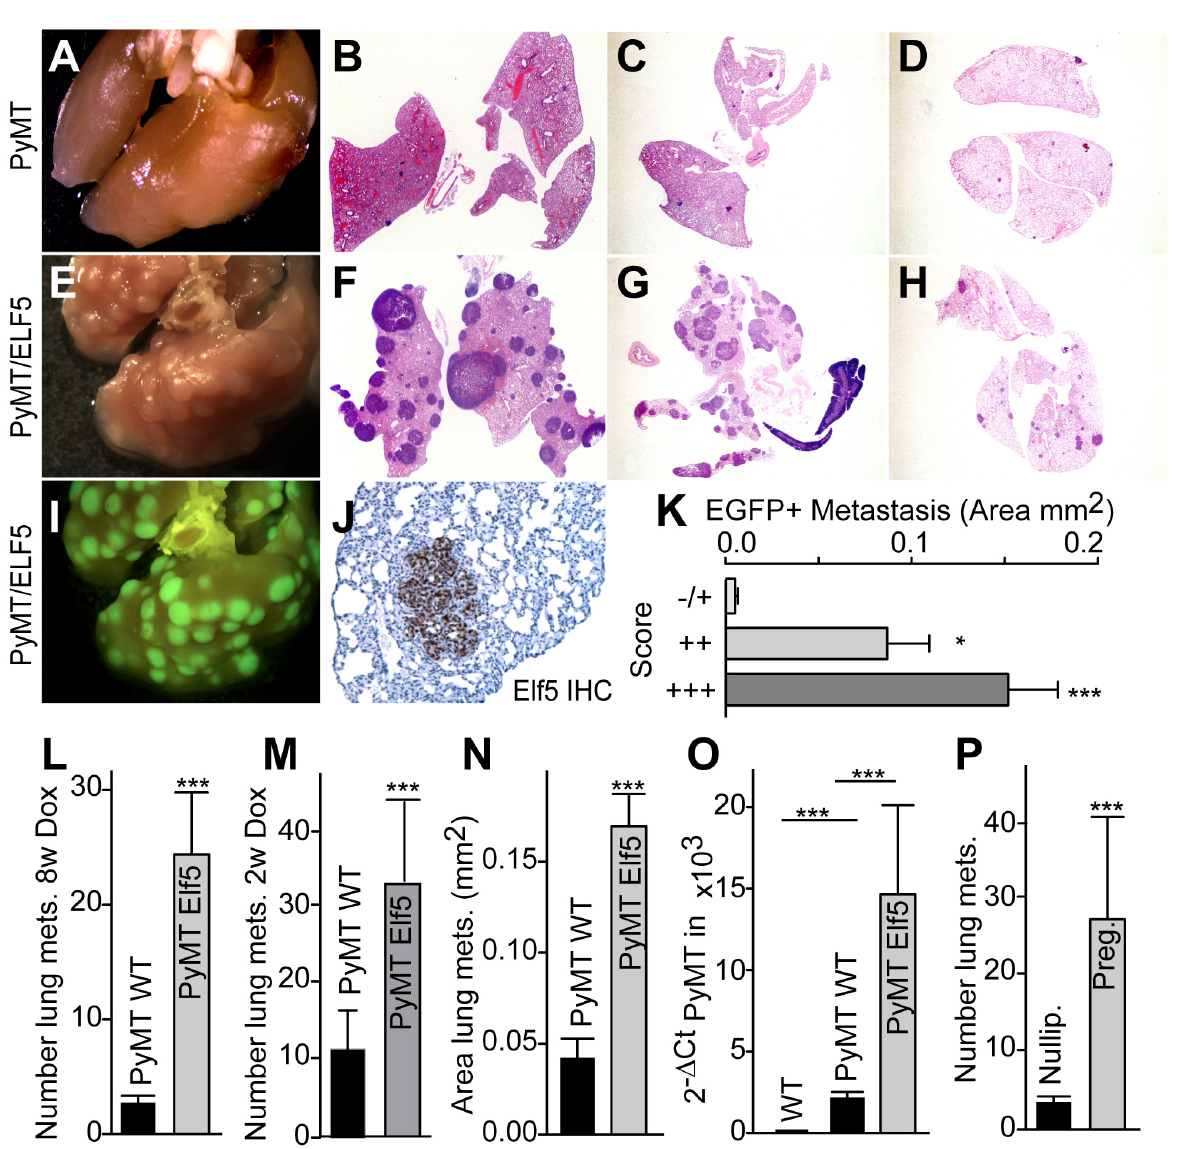
Fig 4. ELF5 expression in the tumor epithelium increases metastases to the lungs. Panel A , appearance of lungs from a control PyMT animal following long term (8 wk) DOX treatment. Panel B , H&E histology of lungs in Panel A. Panels C and D , examples of H&E histology of lungs from control PyMT mice receiving short term (2 wk) DOX treatment. Panel E , appearance of lungs following long term ELF5 expression. Panel F , H&E histology of the lungs in Panel E. Panel G and H , H&E histology of lungs from mice receiving short term induction of ELF5. Panel I , visualization of EGFP of the lungs in Panel E. Panel J , example of IHC staining for ELF5 in a PyMT/ELF5 lung metastasis. Panel K , relationship between the size of an individual lung lesion and the IHC score for ELF5 level (combining intensity and percent positivity). Panel L and M , quantification of the number of metastases in the lungs of the mice with the indicated genotypes after long or short term DOX exposure respectively. Panel N , metastatic behavior of the indicated genotypes expressed as an area. Panel O , PyMT expression measured by qPCR in the blood of mice of the indicated genotypes. Panel P , comparison to the number of metastases driven by pregnancy. Labels are pregnancy (preg.) and nulliparous (nullip.). Raw data for panels K, L, M, N, O, and P can be found at S3